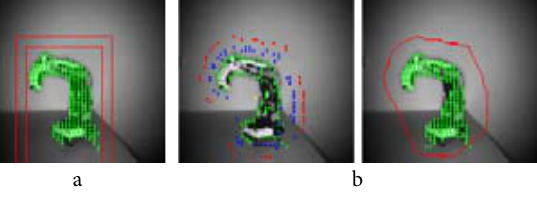
Fig. 7. Security zones: a – static; b – dynamic